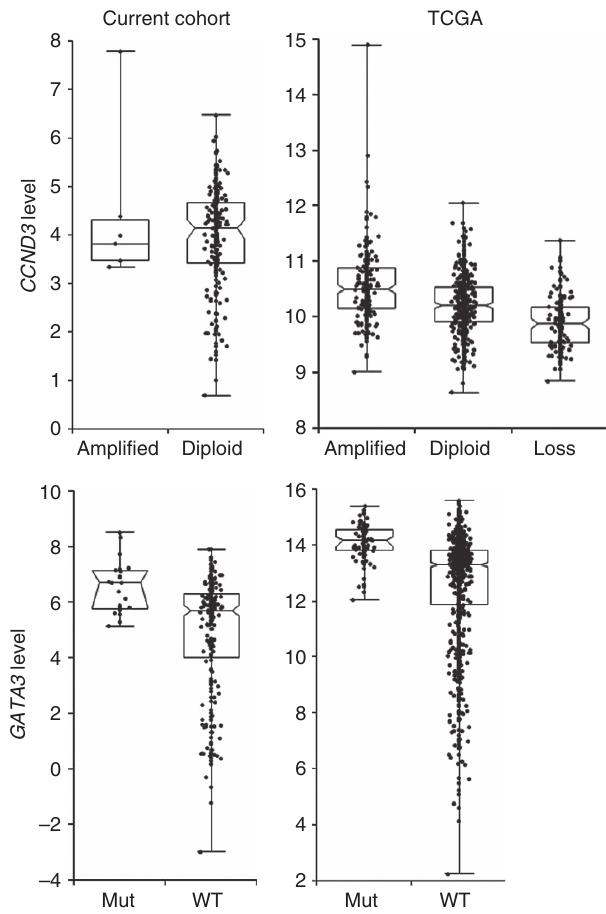
Figure 2 | Boxplots of CCND3 and GATA3 expression. All y axes show expression levels in our cohort ( n ¼ 266, left panels, log2-FPKM) and from TCGA cases ( n ¼ 960, right panels, RNA Seq V2 RSEM, log2) according to copy-number state of CCND3 (top panel, our cohort n ¼ 7 amplified, TCGA n ¼ 152 with loss and n ¼ 233 amplified) and GATA3 mutation state (bottom panel, our cohort n ¼ 25 mutated, TCGA n ¼ 95 mutated).The box is bounded by the first and third quartile with a horizontal line at the median, whiskers extend to the maximum and minimum value. The notch shows the 95% CI of the